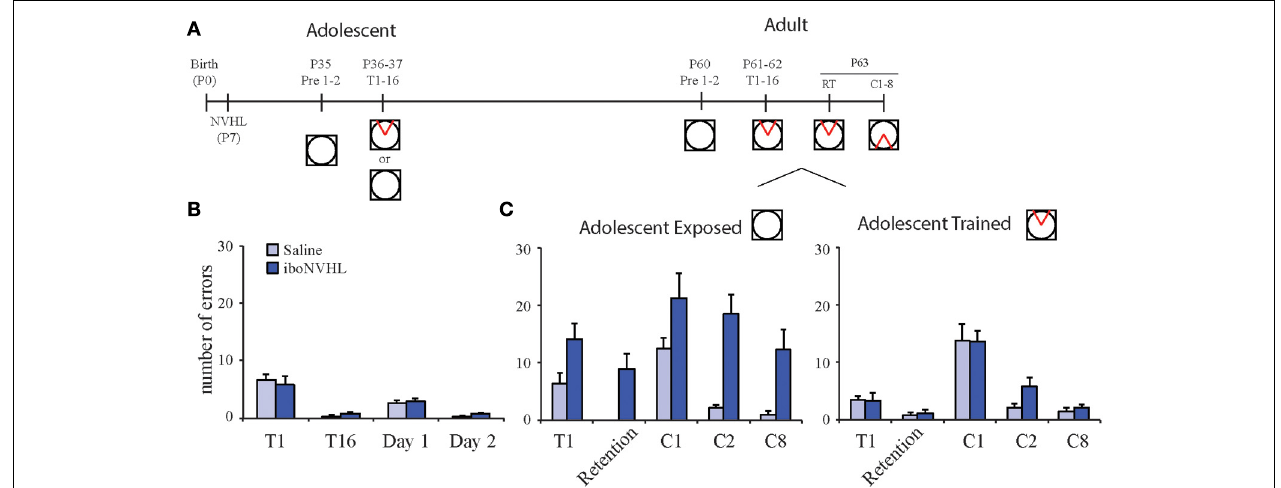
FIGURE 5 | Adolescent experience alters adult behavior in iboNVHL animals. (A) At postnatal day 35 (P35), iboNVHL animals were habituated to the room on the stationary arena for two 10min sessions with a 10min inter trial interval. Adolescence training consisted of eight trials per day for 2 days (P36 and P37). To control for noncognitive experience, a group of adolescent animals was received the same experience with the shock off. (B) During